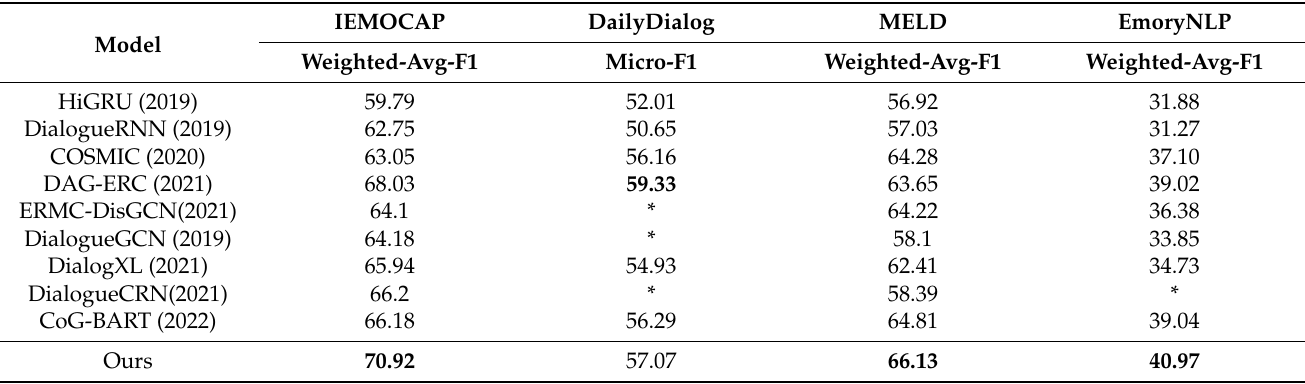
Table 3. Overall performance on the four